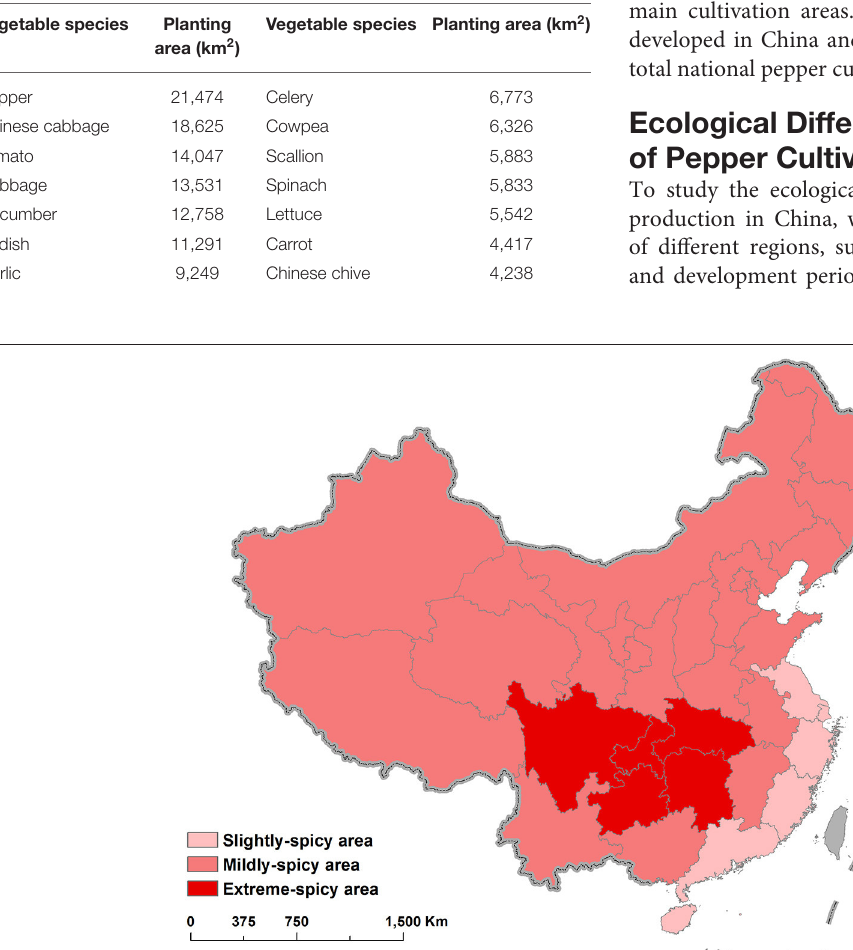
TABLE 1 | Annual planting area of the 20 major vegetable crops in China, as of 2019.